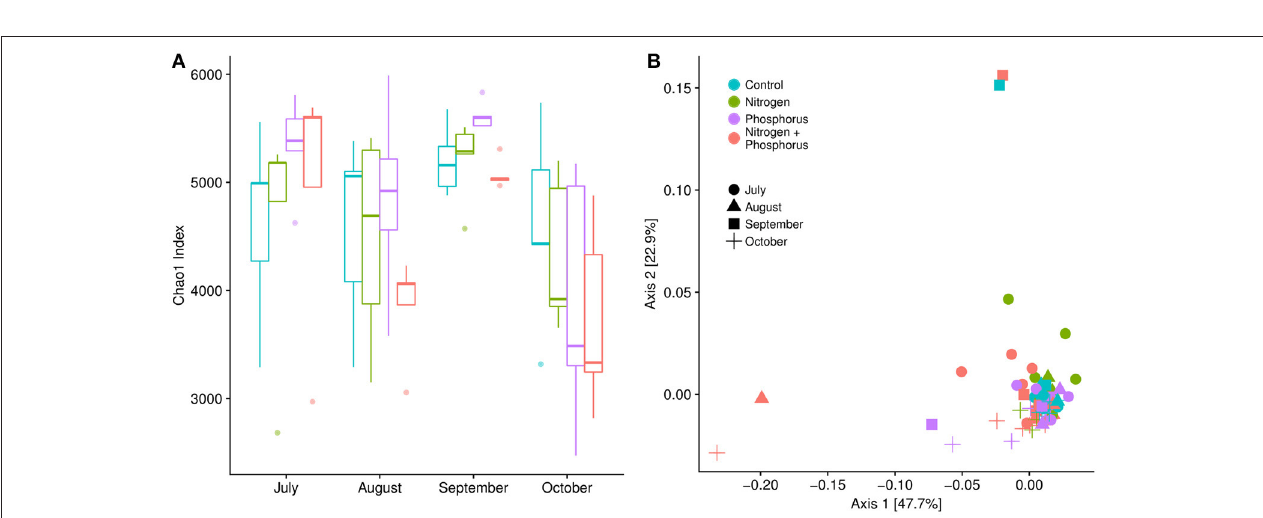
FIGURE 4 | (A) Alpha diversity of the microbial communities associated with Siderastrea siderea over time, calculated using the Chao1 index. Microbial alpha diversity in September was statistically different from alpha diversity metrics in August and October (Kruskal-Wallis test: p < 0.01; FDR-corrected Games-Howell post-hoc test: p < 0.01). (B) Beta diversity was calculated using a Bray-Curtis dissimilarity matrix and plotted on an MDS (multidimensional scaling) graph. Beta-diversity metrics were not different over time, but were instead significantly different between treatments (Adonis, p = 0.01). Pair-wise comparisons showed that the